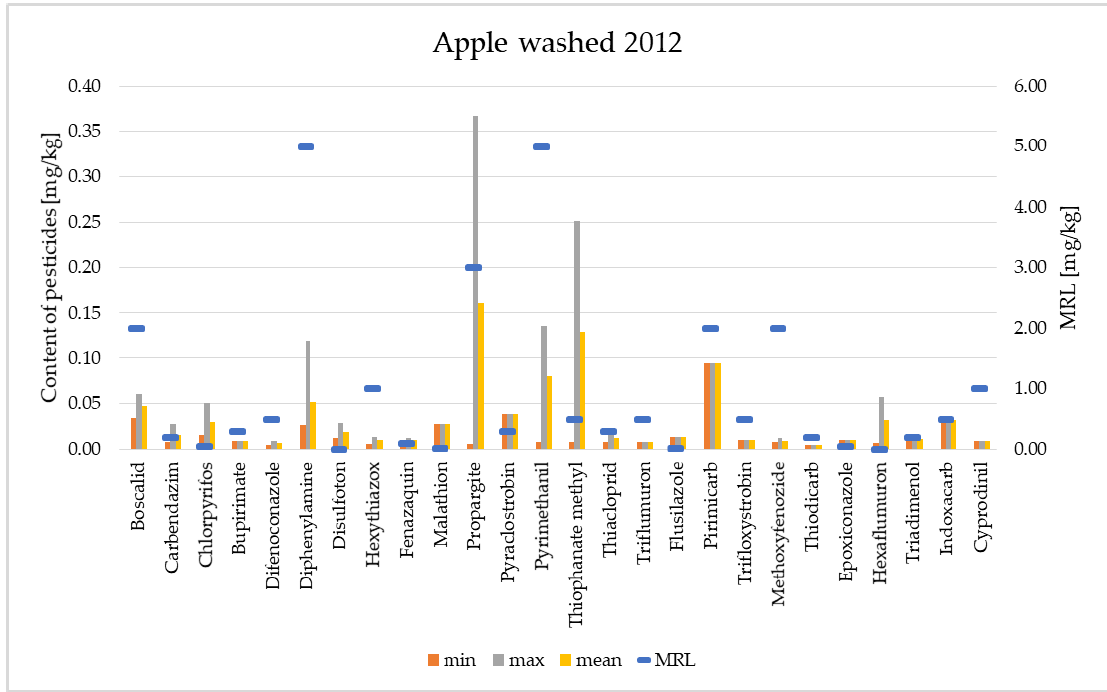
Figure 15. Content of pesticides in samples of apples washed with water (2012).